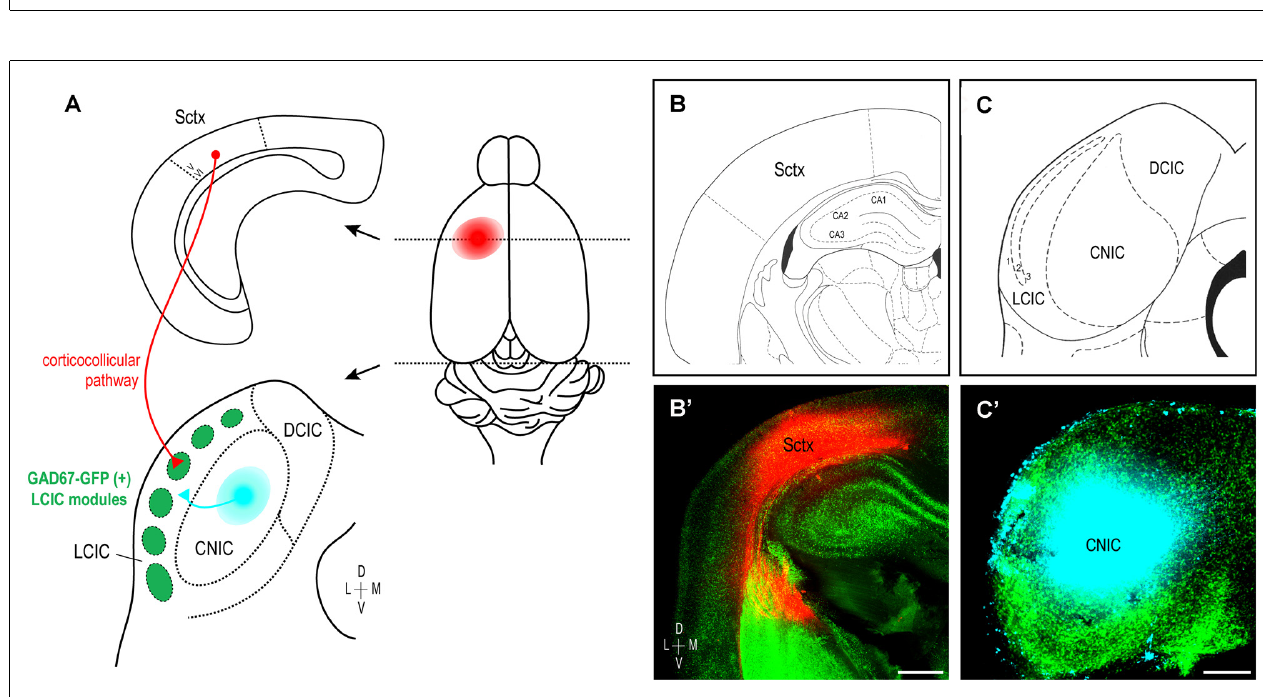
FIGURE 6 | Quantification of discrete somatosensory projection patterns with respect to the LCIC modular-matrix framework at P12. Significantly different cross-correlation y-intercept values for biocytin and GAD vs. biocytin and CR ( p < 0.001) confirm projection patterns that overlap modular zones and are complementary to the LCIC matrix (A) . Linear regression shows clear disparity of y-intercept values for the two conditions. A representative P12 cross-correlation function of somatosensory and GAD labeling in (B) contrasts with that of somatosensory and CR labeling in (C) . Namely, the function shapes are essentially the inverses of each other.